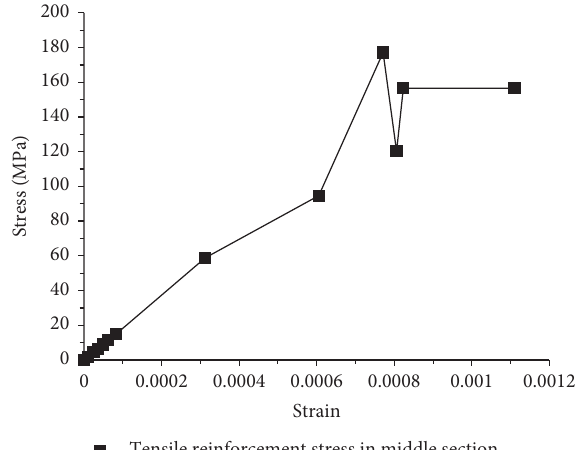
Figure 34: Stress/strain relation curve of the midspan of the tensile rebar.